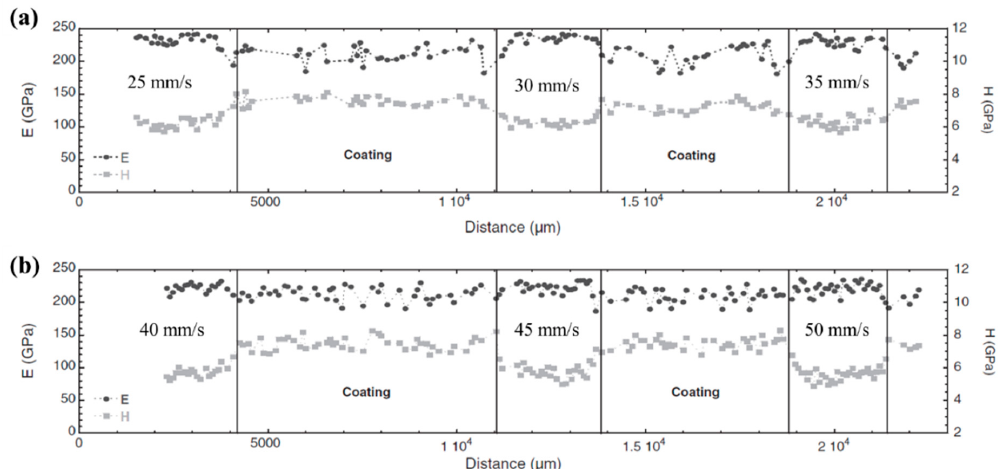
Figure 17. Elastic modulus and hardness values obtained from indentation lines carried out along the transversal directions of the re-melted beads subjected to ( a ) high energetic conditions: 25 mm/s, 30 mm/s and 35 mm/s, and ( b ) low energetic conditions: 40 mm/s, 45 mm/s and 50 mm/s (adapted from reference [84] , with permission from © Elsevier).